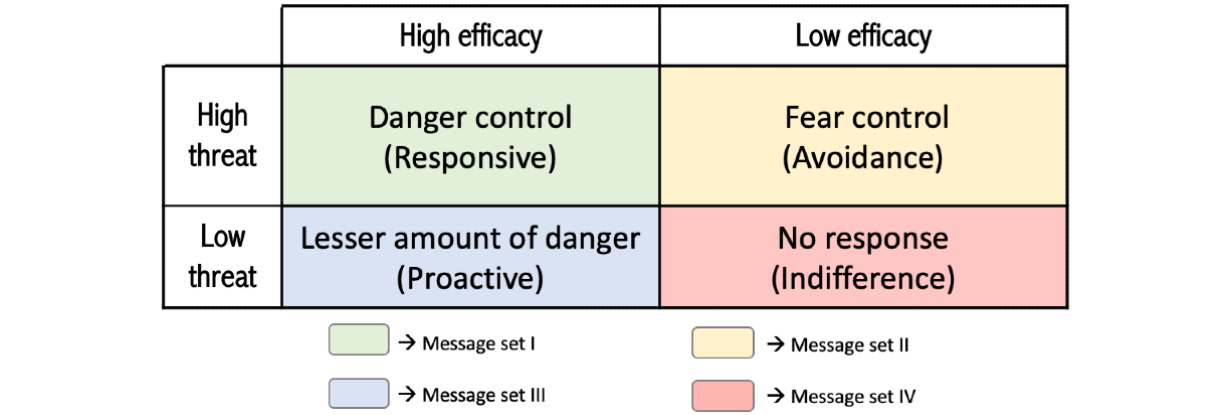
Figure 2. Extended Parallel Process Model potential response states and message